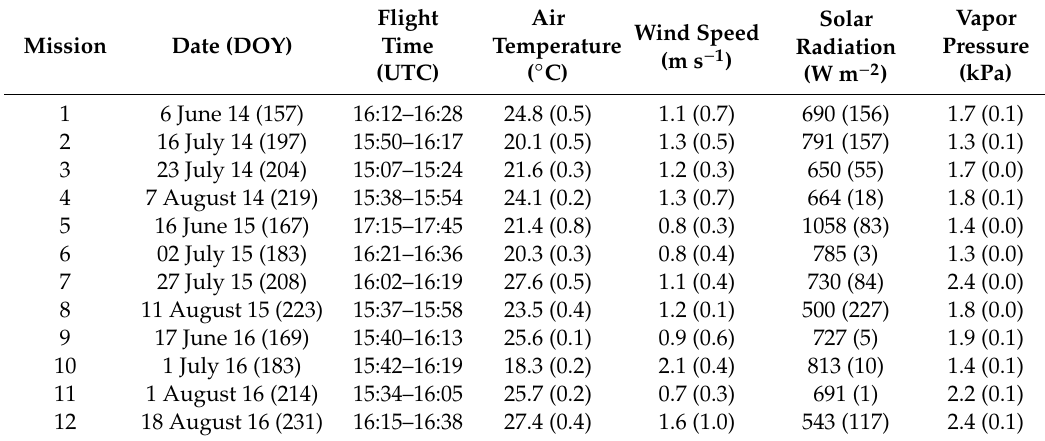
Table 3. Airborne